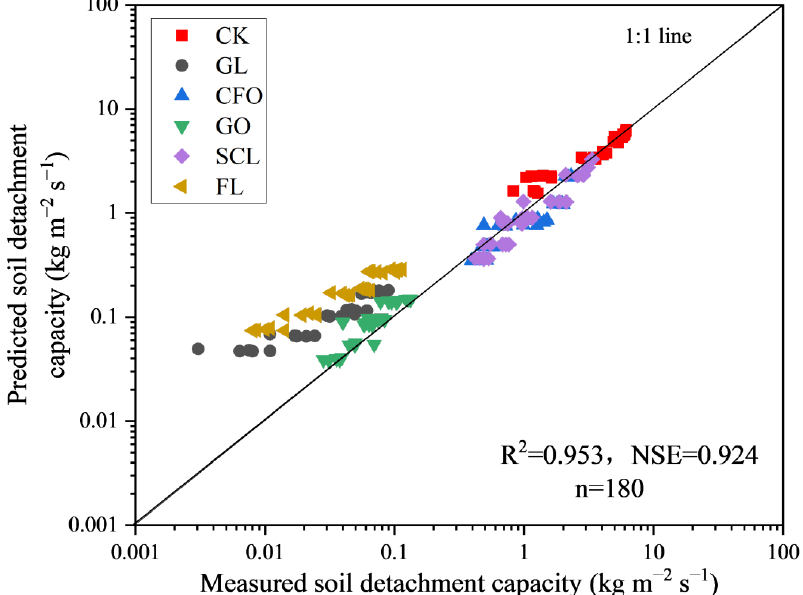
Figure 9. Comparison between measured and predicted soil detachment capacity by Equation (11). Note: CK, bare land; CFO, orchard with no cover; SCL, farmland; GL, grassland; GO, orchard with grass cover; FL, forest.